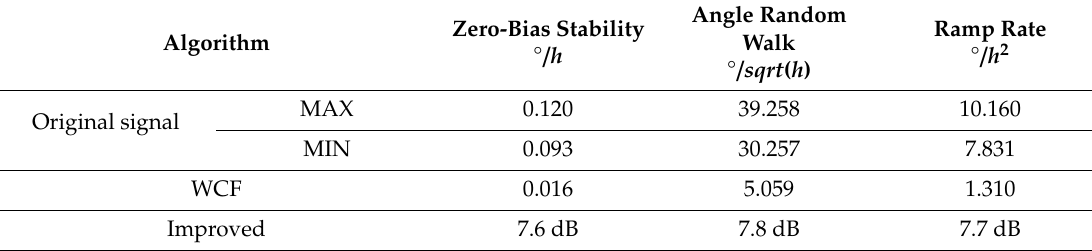
Table 3. Optimization results of yaw angle (sky)